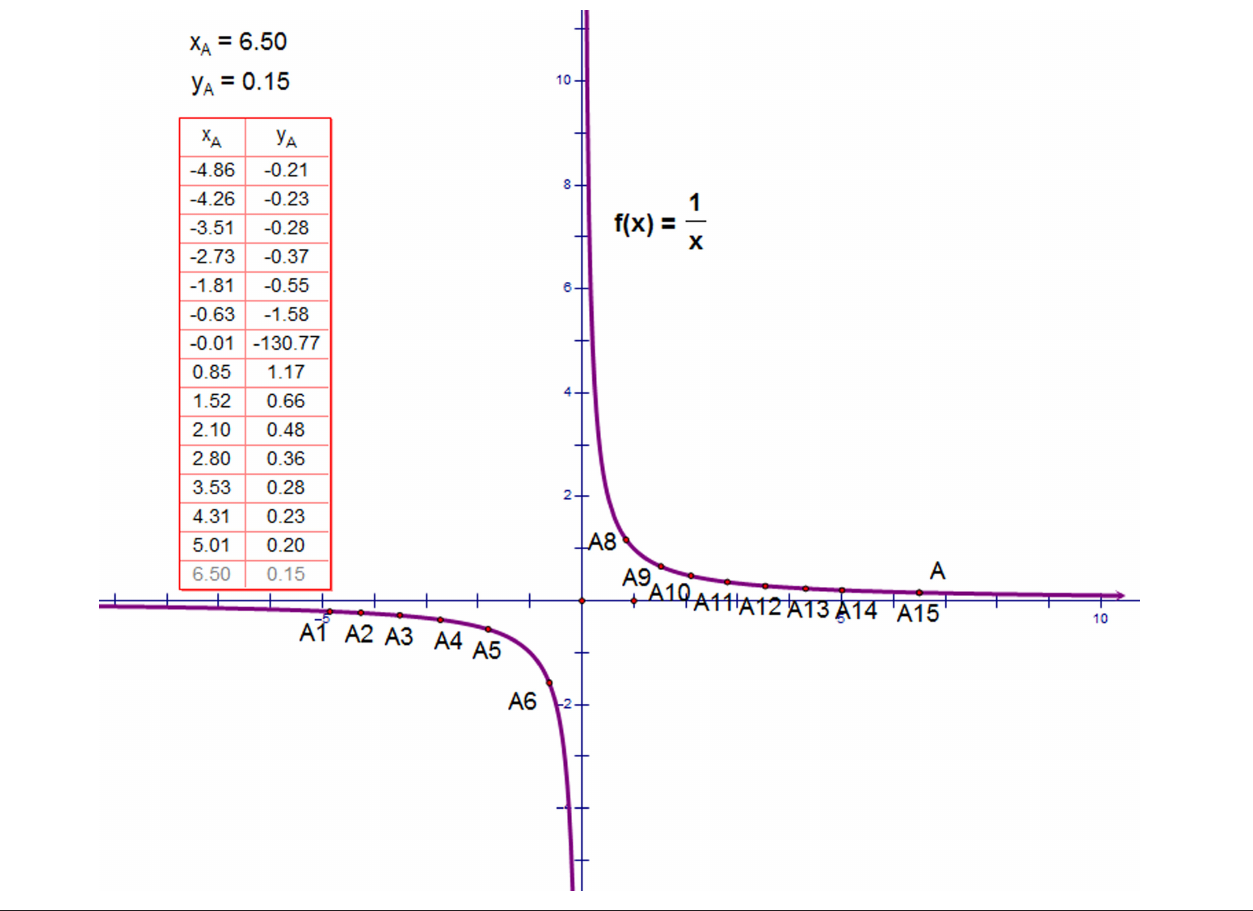
FIGURE 6: Student MT’s function